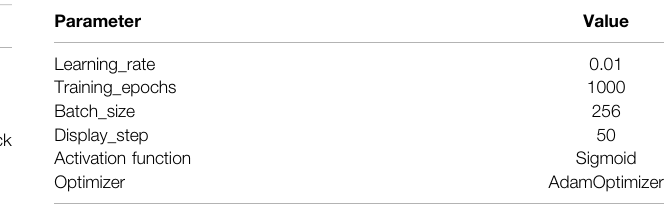
TABLE 1 | Scene event description. TABLE 2 | SAE